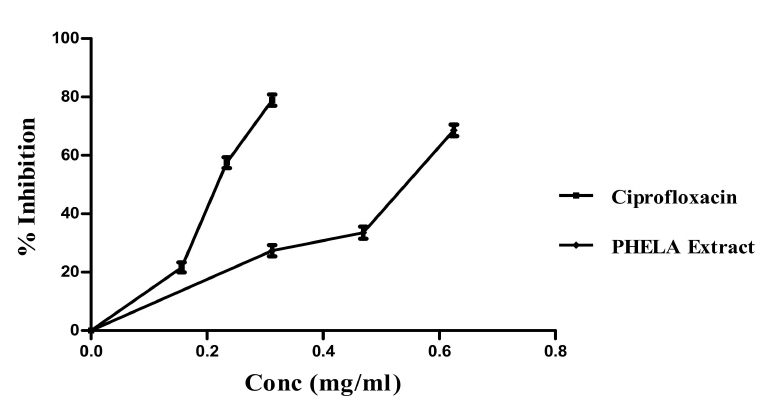
Figure 5. S. aureus biofilm inhibition of PHELA ® extract and ciprofloxacin.